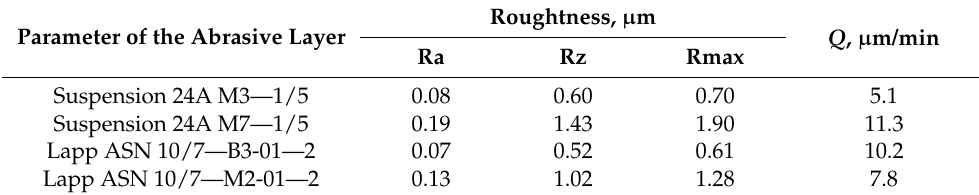
Table 3. Results of lapping of LNSC plates with a free and fixed abrasive.